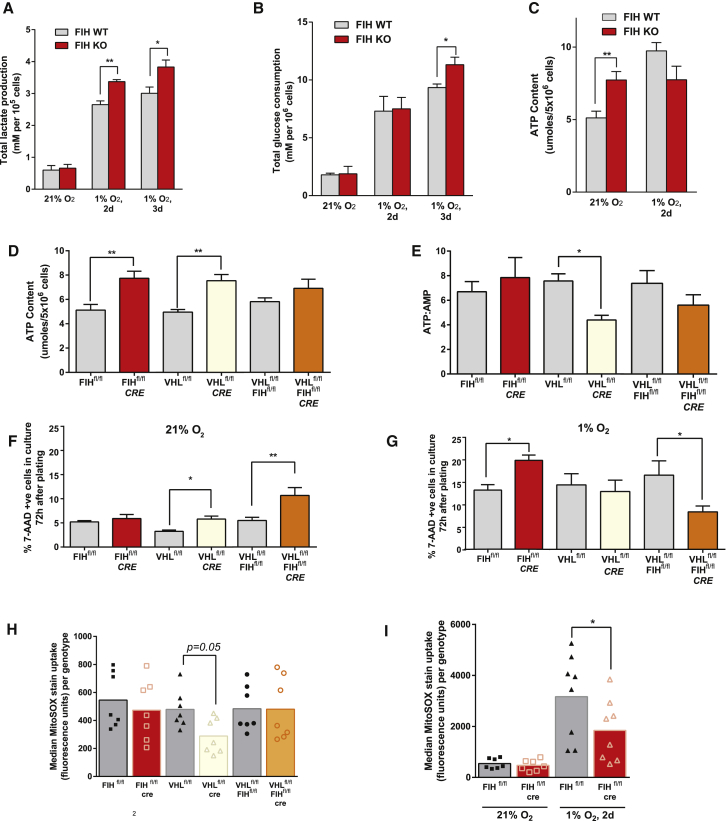
FIH Loss Promotes Glycolysis in Hypoxia, but Not Normoxia(A) Enzyme-based colorimetric assay of culture media lactate.(B) Enzyme-based colorimetric assay of culture media glucose.(C) HPLC-based ATP measurements from cell lysates.(D) HPLC-based ATP measurements from cell lysates.(E) AMP:ATP ratio in cell lysates.(F) 7′-AAD flow cytometric apoptosis assay for cells cultured in atmospheric oxygen.(G) 7′-AAD flow cytometric apoptosis assay for cells cultured in 1% oxygen for 3 days.(H) Flow cytometry; histogram of cell count versus MitoSOX (superoxide stain) fluorescence, with shaded graph representing unstained controls. Three experiments were performed with two biological replicates each; the histogram provided is representative of one of these experiments.(I) Flow cytometry; histogram of cell count versus MitoSOX fluorescence, with shaded graph representing unstained controls.∗p < 0.05, ∗∗p < 0.01. Data are represented as means ± SEM. For grouped data (A–C), a two-way ANOVA was used. For multiple comparisons (D–G), a one-way ANOVA was used. For pairwise comparisons (H and I), a two-tailed Student's t test was used. n = 3 independent cell culture samples per genotype, unless otherwise specified. See also Figure S2.